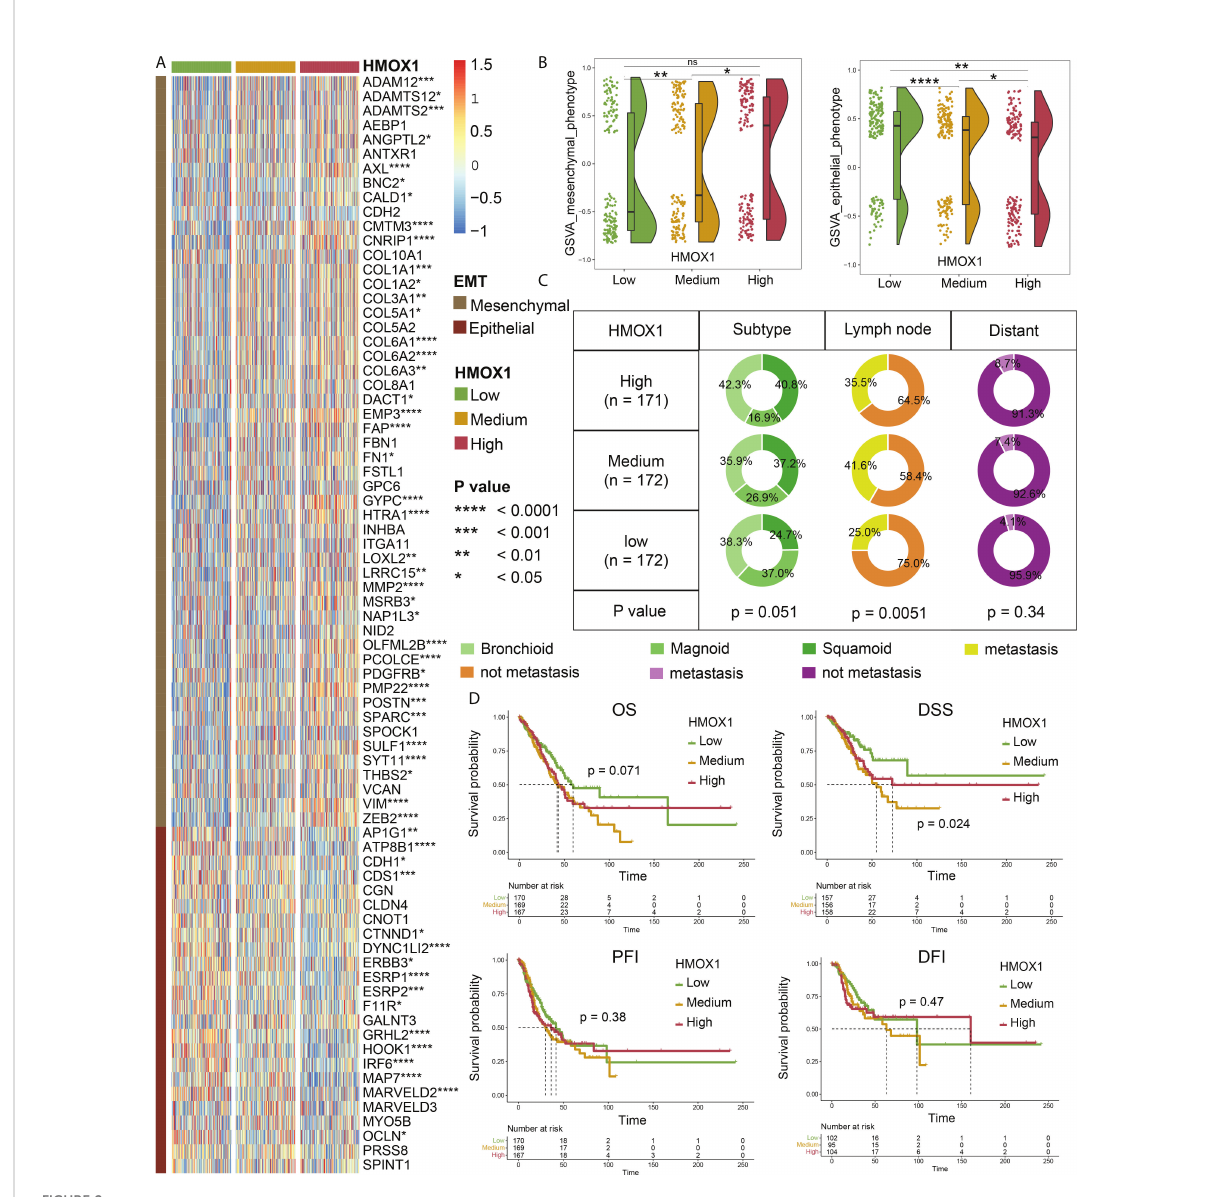
FIGURE 2 The effect of HMOX1 on metastasis in lung adenocarcinoma (LUAD). (A) Differences in the expression of EMT signature genes among high, medium, and low HMOX1 groups. (B) Differences in the EMT scoring between high, medium, and low HMOX1 groups. (C) Differences in the LUAD subtype, lymph node metastasis, and distant metastasis among high, medium, and low HMOX1 groups. (D) Survival analyses for the high, medium, and low HMOX1 groups. OS, overall survival; DSS, disease-speci fi c survival; PFI, progress-free interval; DFI, disease-free interval. NS, not signi fi cant; *P < 0.05; ** P< 0.01; ***P < 0.001; ****P <